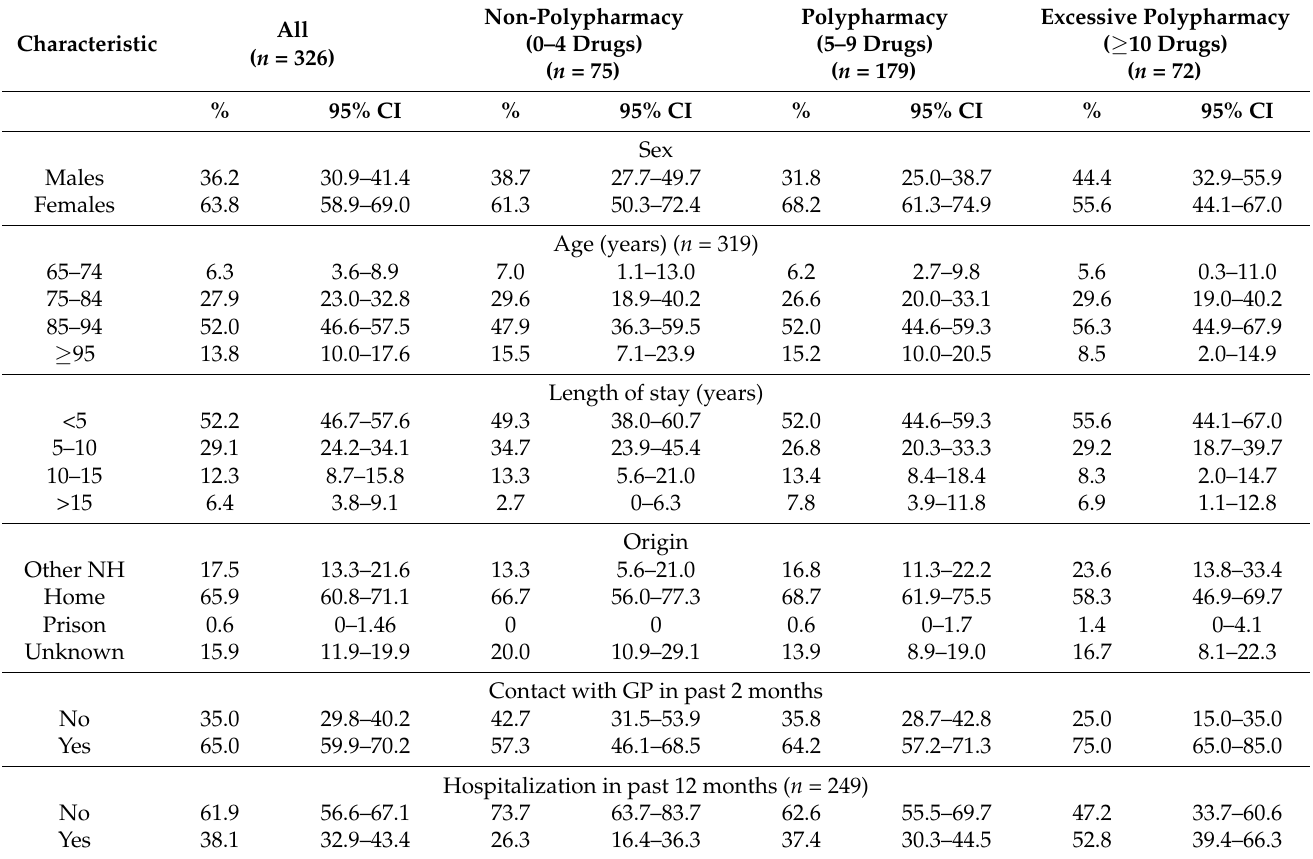
Table 1. Characteristics of the residents in the nursing home (NH) studied, stratified by the level of polypharmacy.